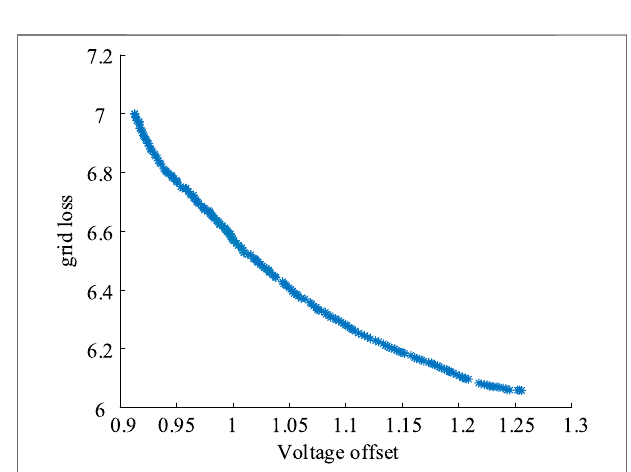
FIGURE 8 | Distribution of Pareto solution in objective function space at 12:00 for IEEE 39-bus system.